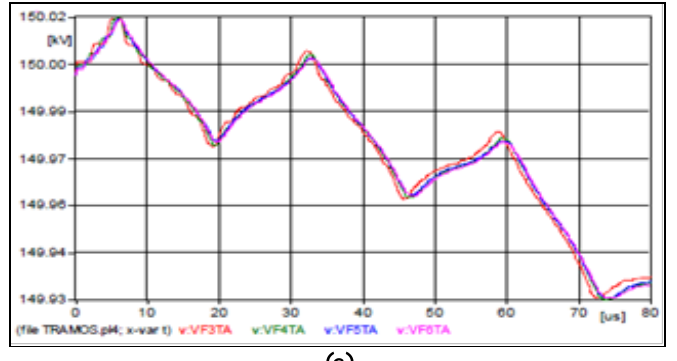
Figura 5: Respuesta al final de la línea cuando es modelada mediante 3, 4, 5 y 6 tramos (VF3TA, VF4TA, VF5TA y VF6TA, respectivamente). (a) Perturbación Tipo descarga atmosférica. (b) Perturbación tipo maniobra. (c) Detalle de la respuesta a frecuencia industrial (60 Hz).